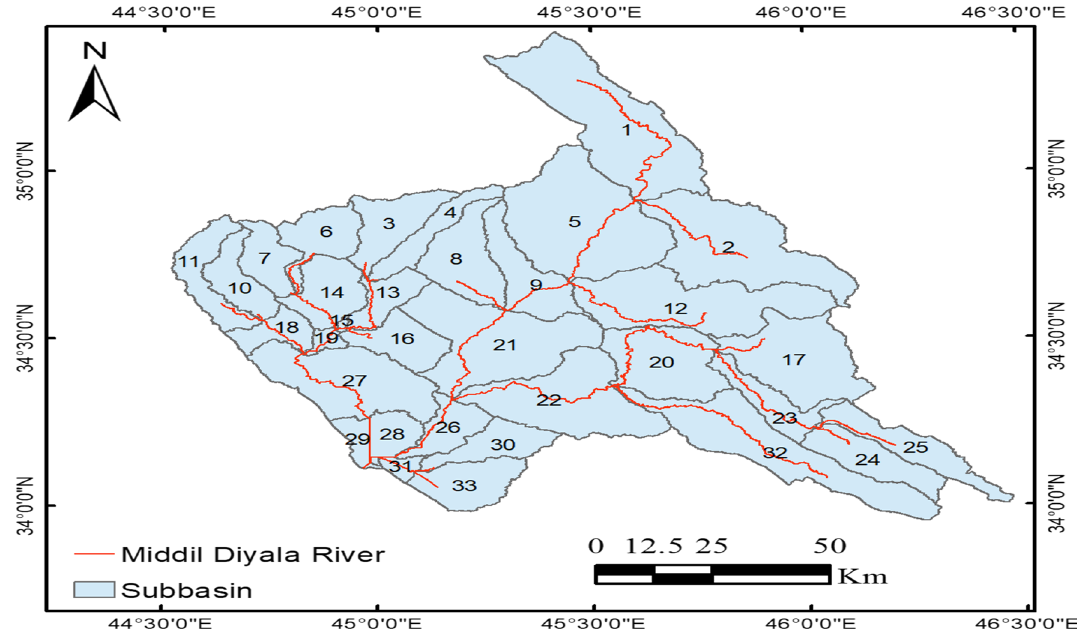
Fig. 12 SWAT-DEM delineated subbasins of Hemren dam reservoir